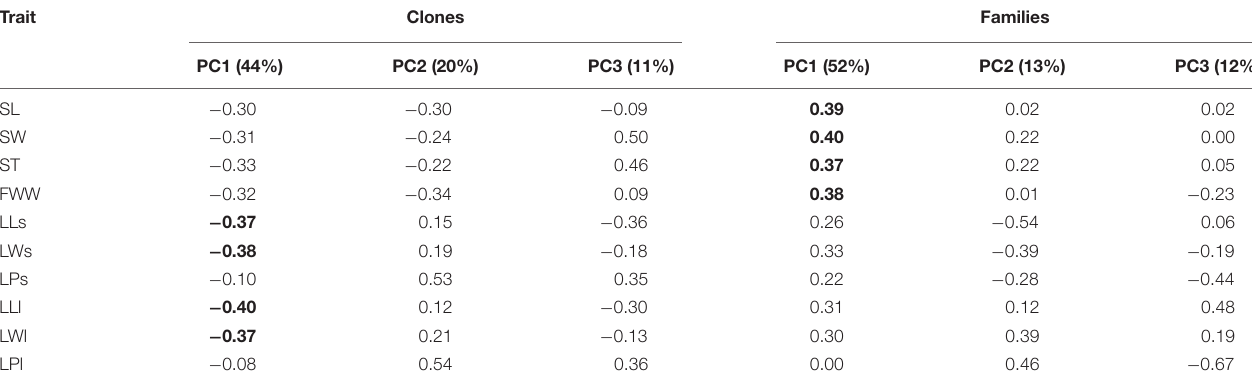
TABLE 6 | Loadings of the first three principal components for the clone and family